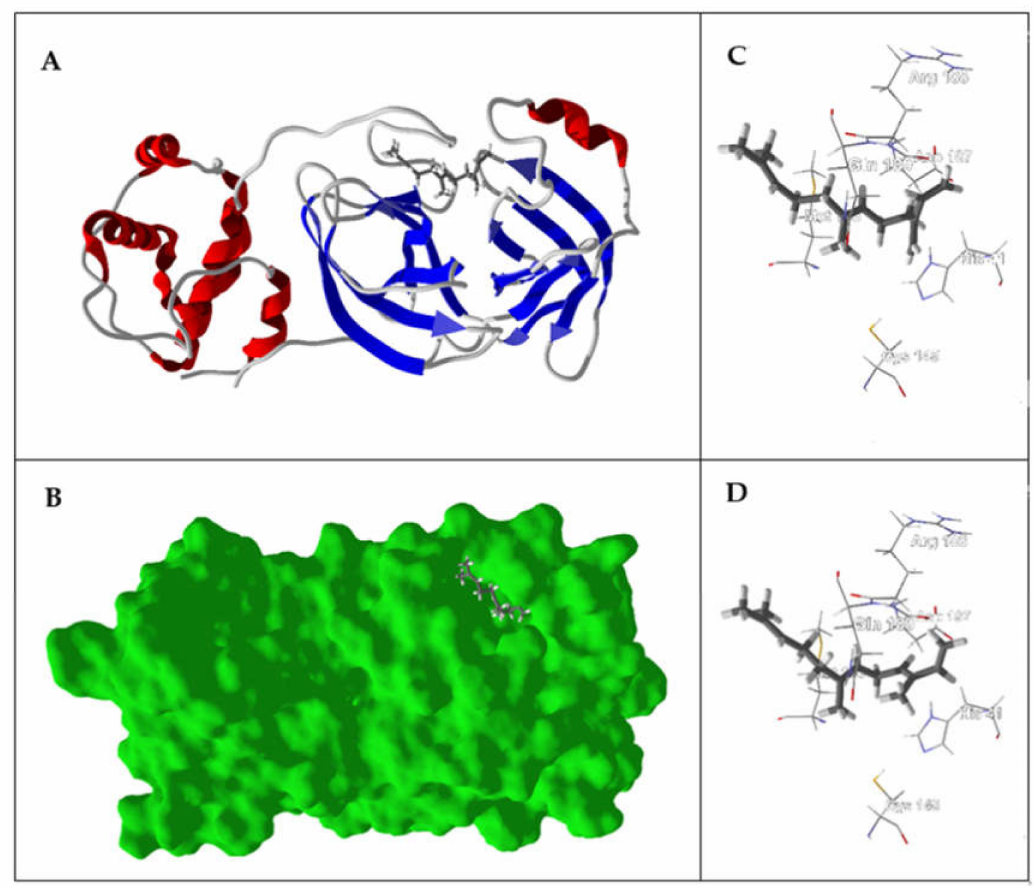
Figure 1. Lowest-energy docked poses of ( E )- β -farnesene and ( E , E )- α -farnesene with the SARS-CoV-2 main protease (PDB: 6LU7). ( A ) Ribbon structure of the enzyme and ( E )- β -farnesene. ( B ) Solid structure of the enzyme showing ( E )- β -farnesene in the binding cleft. ( C ) Amino acid residues in proximity to the docked ( E )- β -farnesene. ( D ) Lowest-energy docked pose of ( E , E )- α -farnesene in the enzyme binding